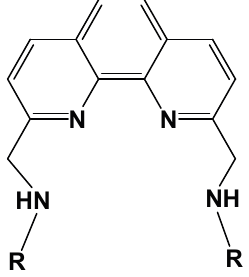
Figure 9. N , N ′ -dialkyl-1,10-phenanthroline-2,9-dimethanamine (L). R = methyl ( 1 ); n -propyl ( 2 ); isopropyl ( 3 ); sec -butyl ( 4 ); tert -butyl group ( 5 ). Numbers in the parentheses correspond to the respective Cu(II)